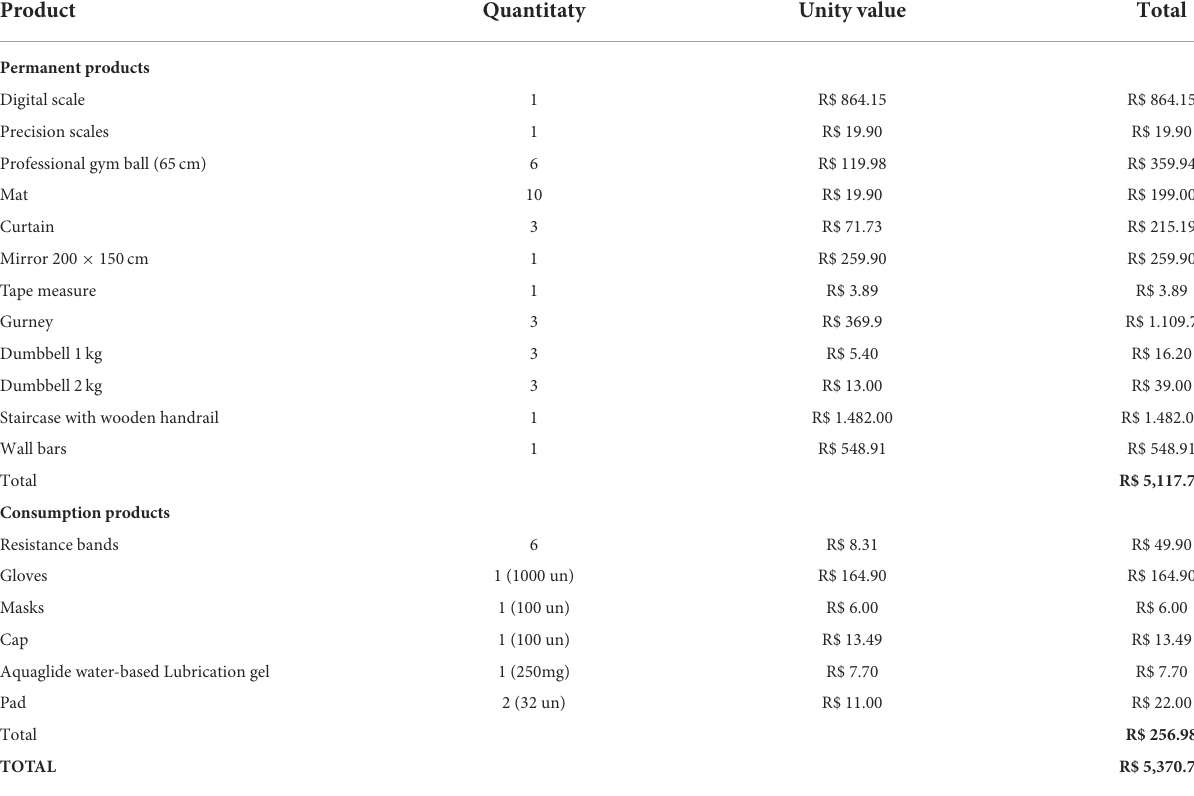
TABLE 3 Description of the materials used for the implementation of the pelvic physical therapy